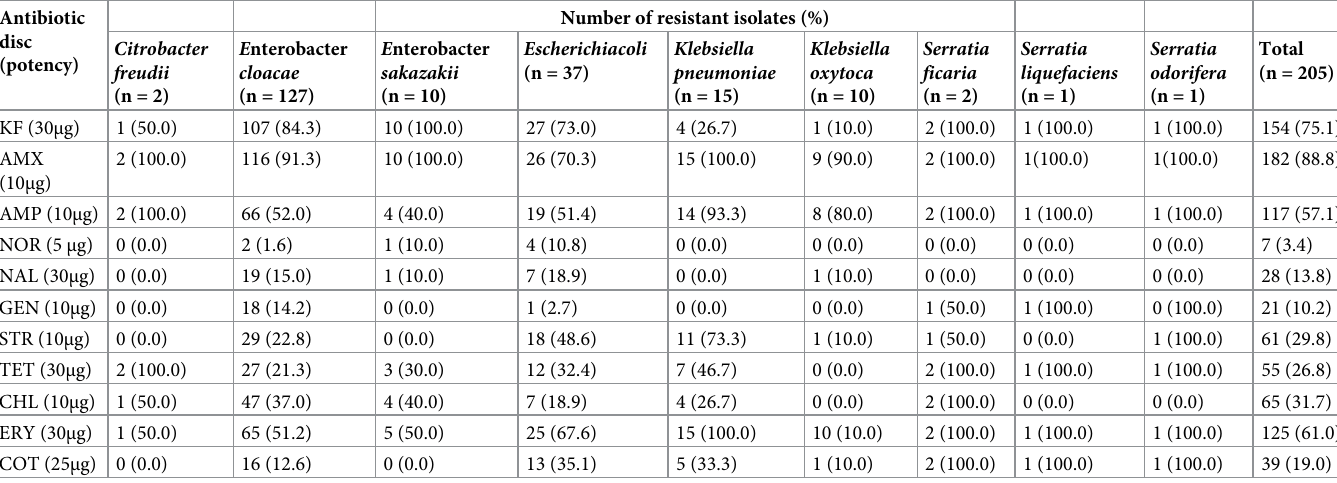
Table 7. Coliform bacterial isolates resistant to each antibiotic tested.